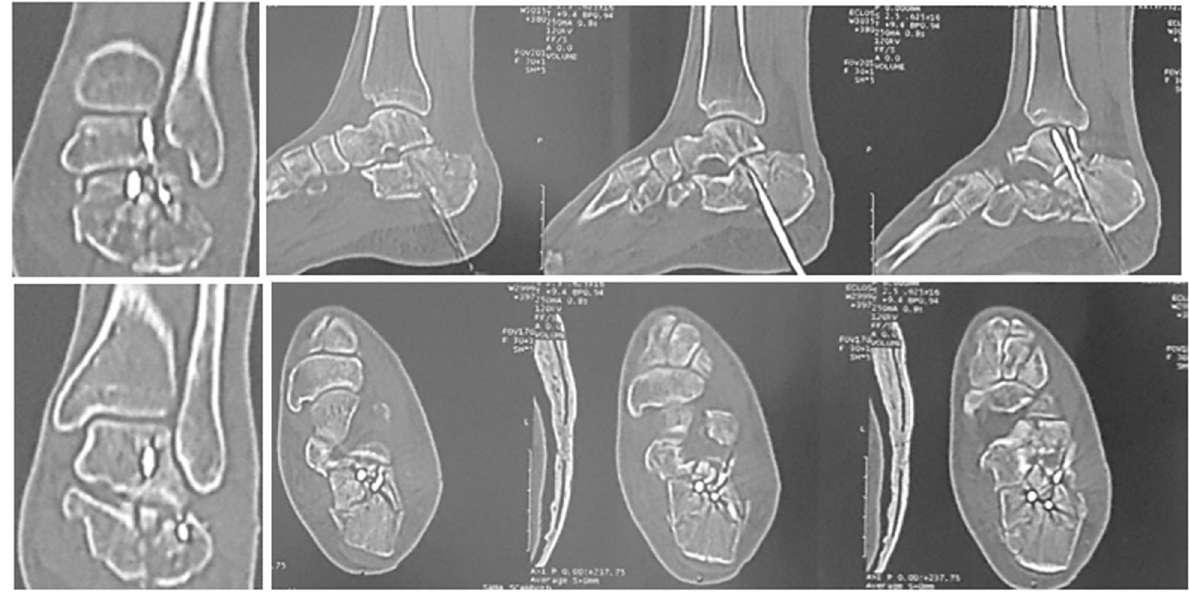
Fig. 3 Postoperative CT for evaluating the articular surface